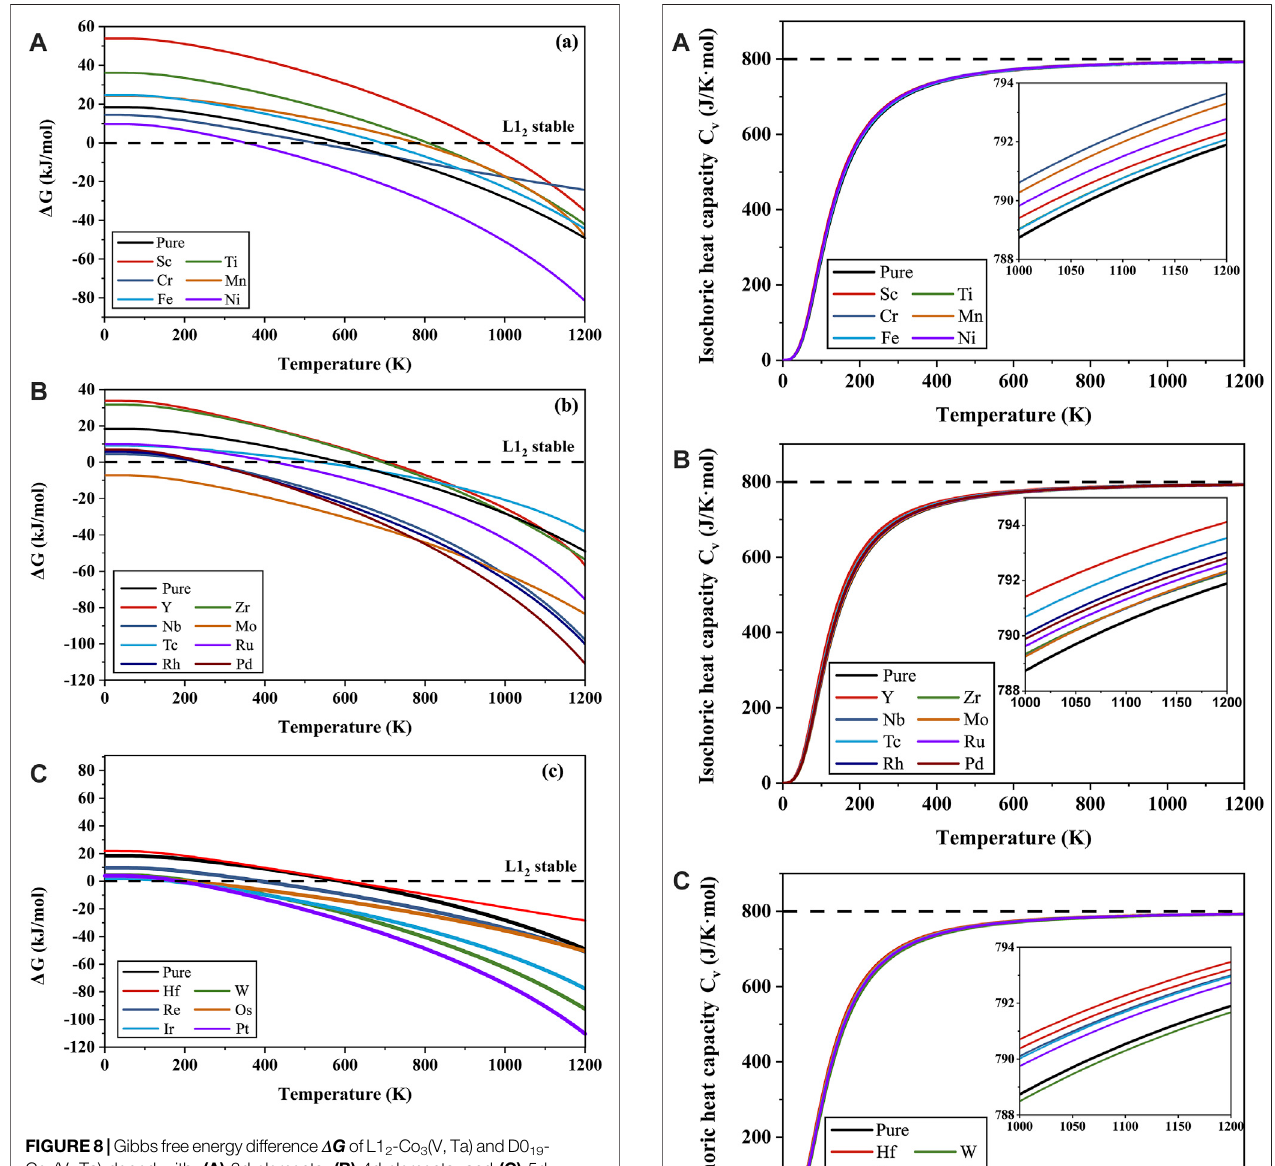
FIGURE8| Gibbsfreeenergydifference Δ G ofL1 2 -Co 3 (V,Ta)andD0 19 - Co 3 (V, Ta) doped with: (A) 3d elements, (B) 4d elements, and (C) 5d elements.